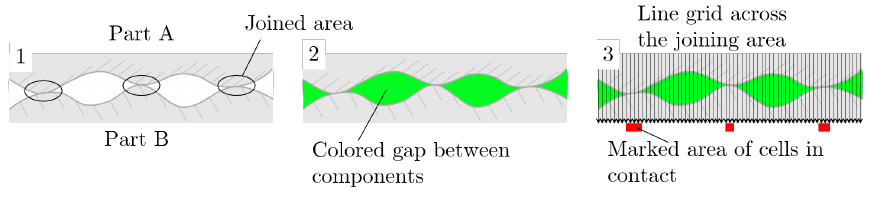
Figure 5. Procedure and principle functionality of the contact area